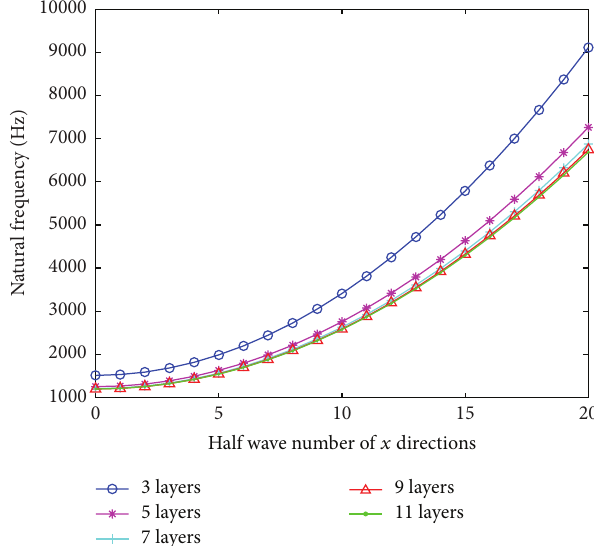
Figure 7: The natural frequency of constrained damping plate with various layers ( 𝑛 = 5 ).